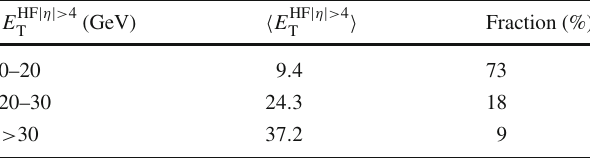
| η | > 4 , their mean T